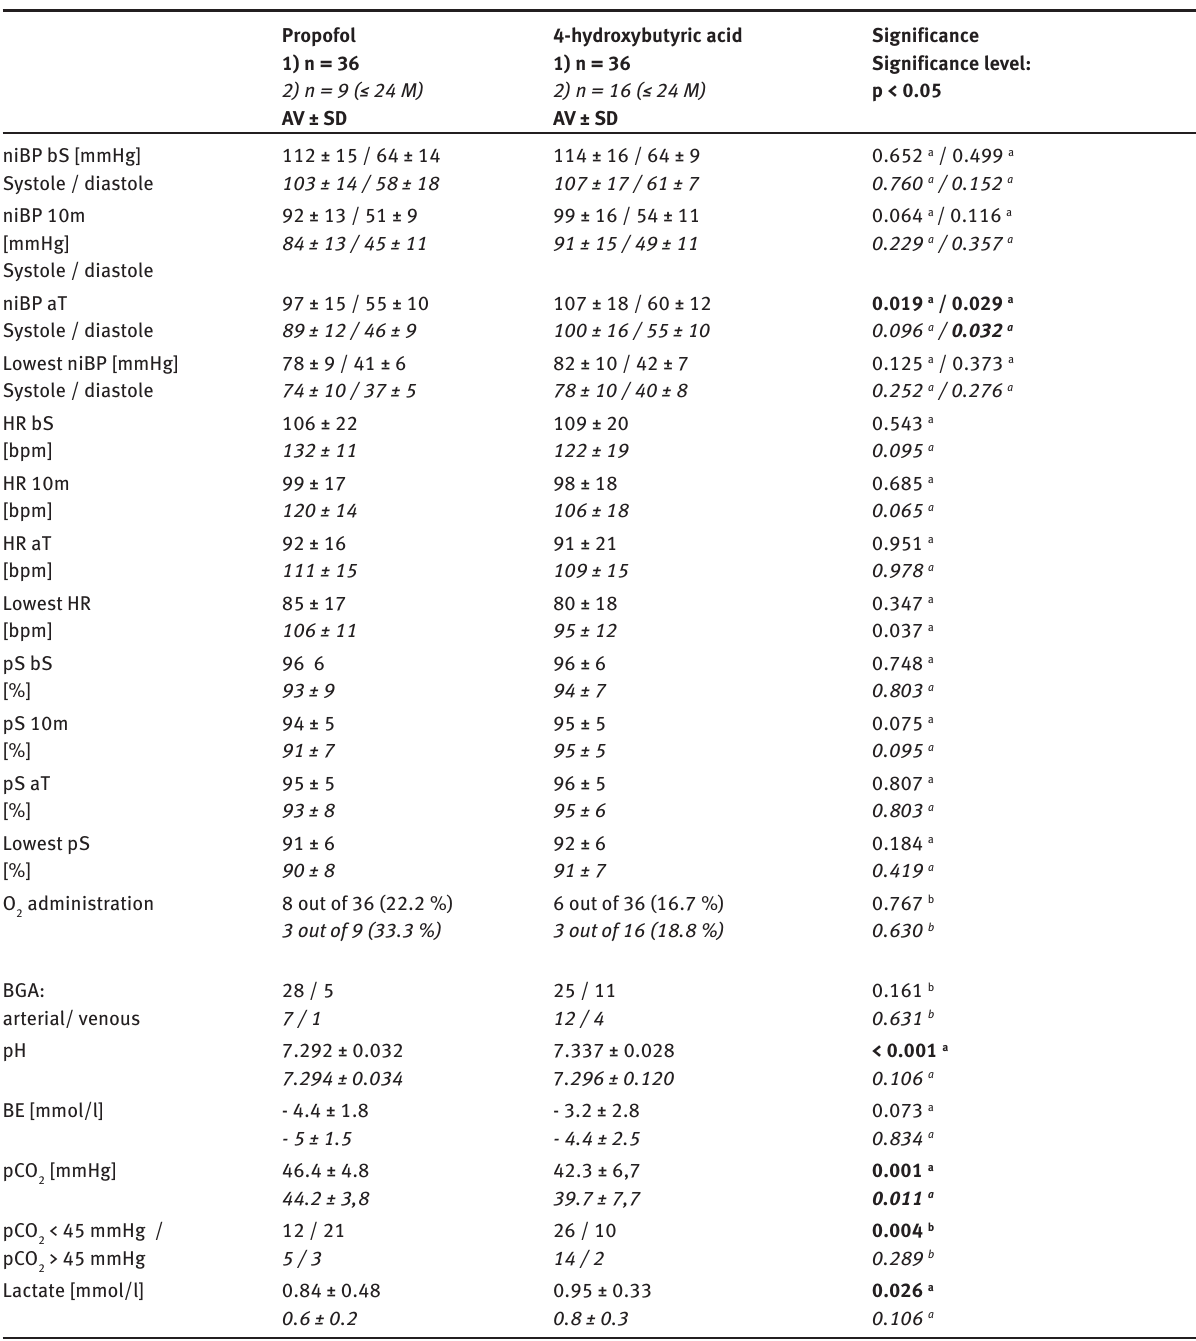
Table 5: Vital parameters, blood gas analyses and oxygen administration in the two groups